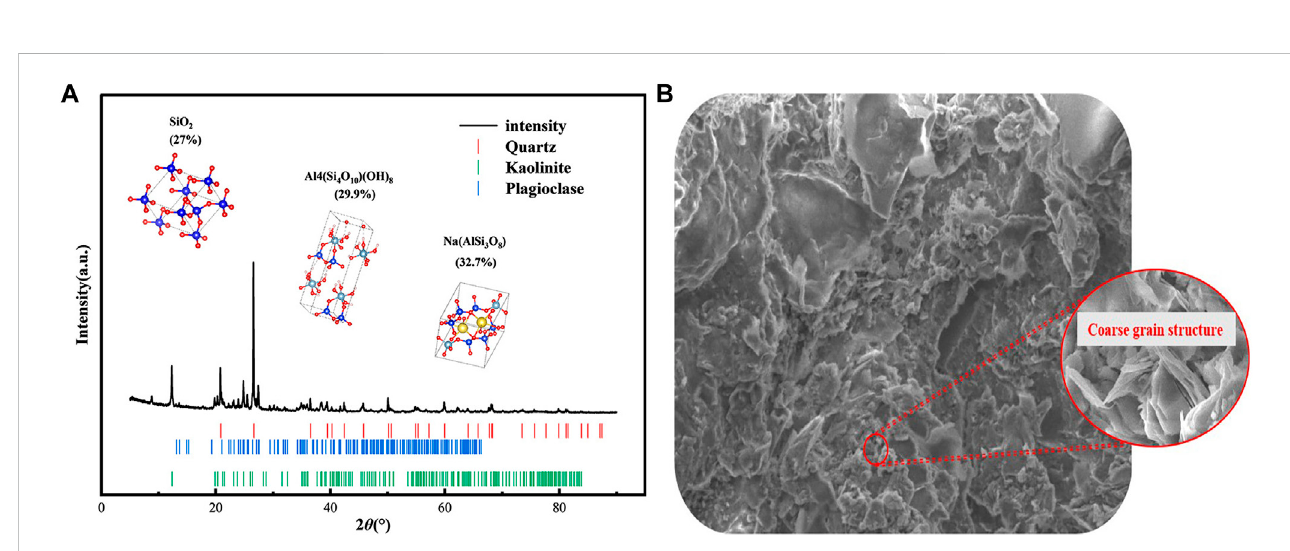
FIGURE 3 Mineral composition and sandstone type determined by